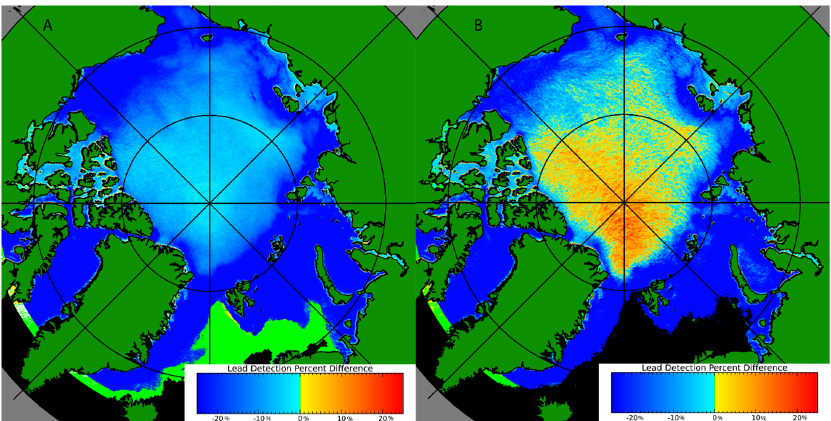
Figure 14. Comparison of the relative detection frequency between the Hoffman [25] and Reiser [35] lead products from 2002–2019. Yellows and reds are used where the Hoffman detection rate is higher, blue to black where Reiser et al.’s is higher; green indicates regions with identical detection rates. The detection rate is the number of days with lead divided by the number of days with product coverage. In Panel ( A ), the detection rate for all sky cover is shown. In Panel ( B ), the detection rate is given from the subset of locations and days where the MODIS clear sky is probably clear in all of the daily overpasses.